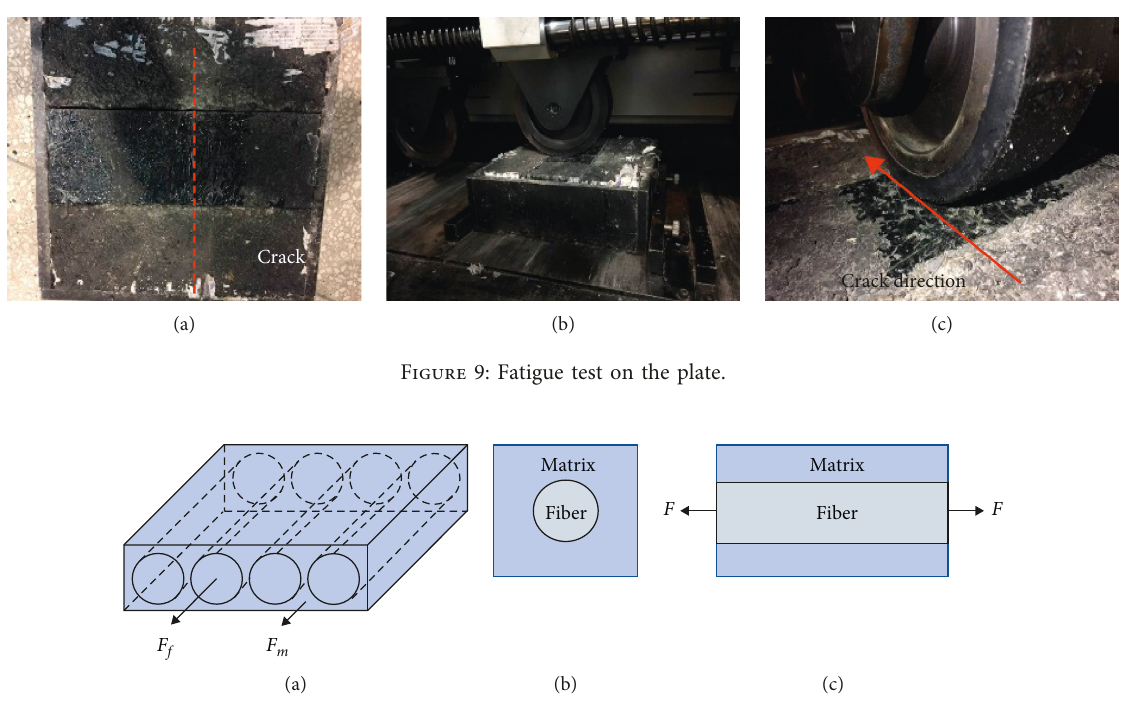
Figure 10: Simplified model of unidirectional continuous composites. Table 5: Tensile elastic moduli of the composite structure through theoretical calculation at room